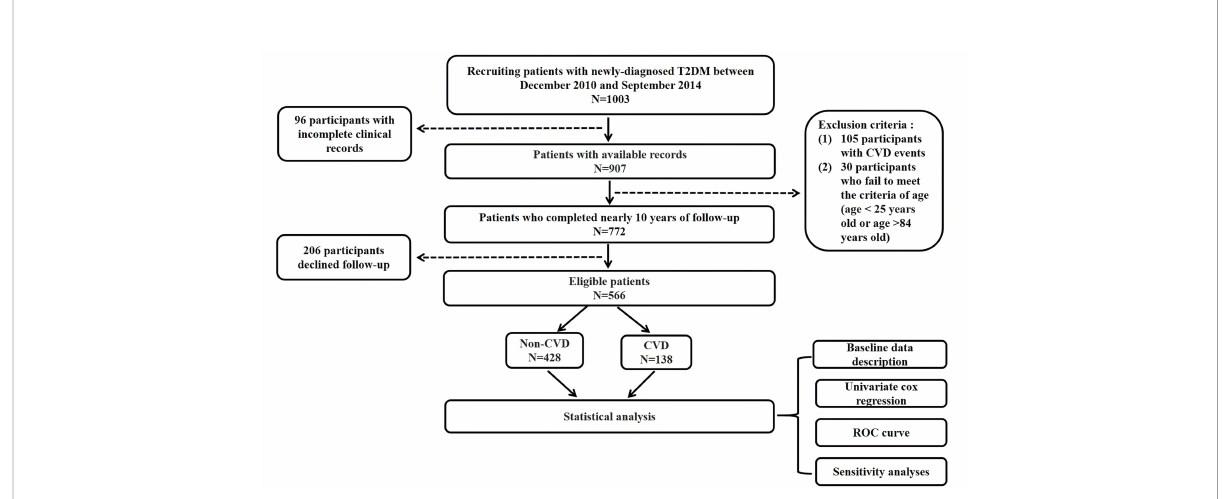
FIGURE 1 Flow chart of study. Legend: The fl ow chart shows the entire research process. T2DM, Type 2 diabetes mellitus; CVD, Cardiovascular disease; ROC, Receiver operating characteristics.